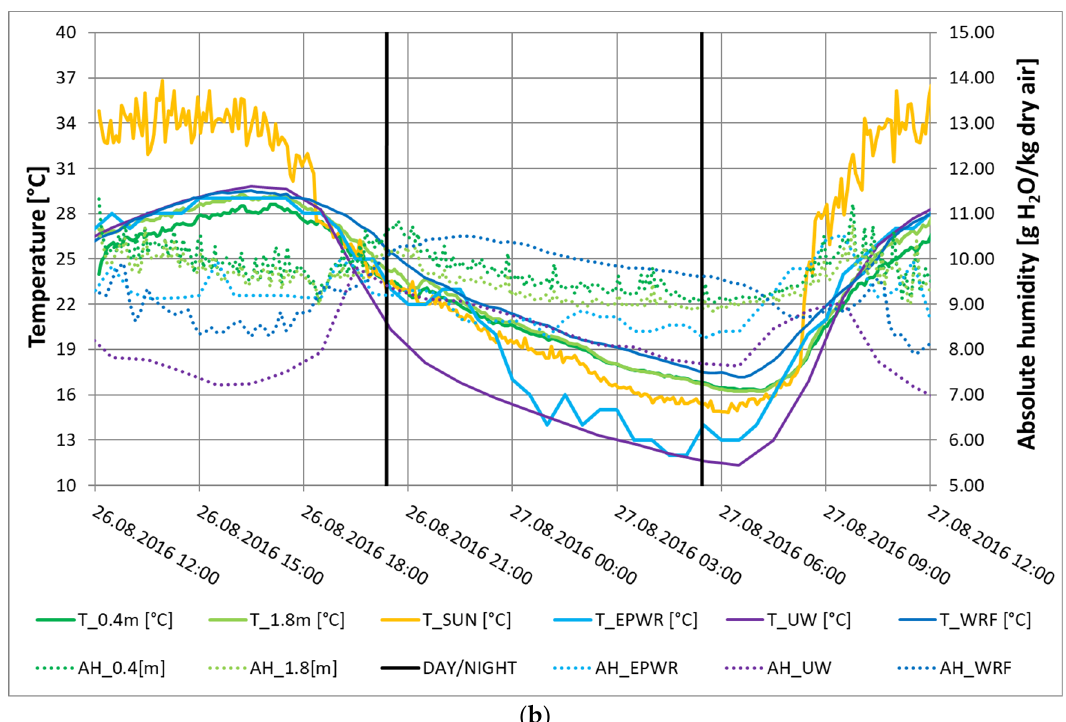
Figure 6. Results of the first temperature and humidity measurements (Period A): 26th / 27th August 2016 (12:00–12:00): ( a ) temperature (T) and relative humidity (RH); ( b ) temperature and absolute humidity (AH). Abbreviations: 0.4—inside of the structure, 40 cm over the ground; 1.8—inside of the structure, 180 cm over the ground; SUN—top shelf (Figure 5); EPWR—measurements at Wrocław Airport; UW—measurements provided by the Observatory of the Department of Climatology and Atmosphere Protection, University of Wroclaw; WRF—results of simulation of weather conditions using WRF model. DAY / NIGHT lines mark the sunrise and sunset.